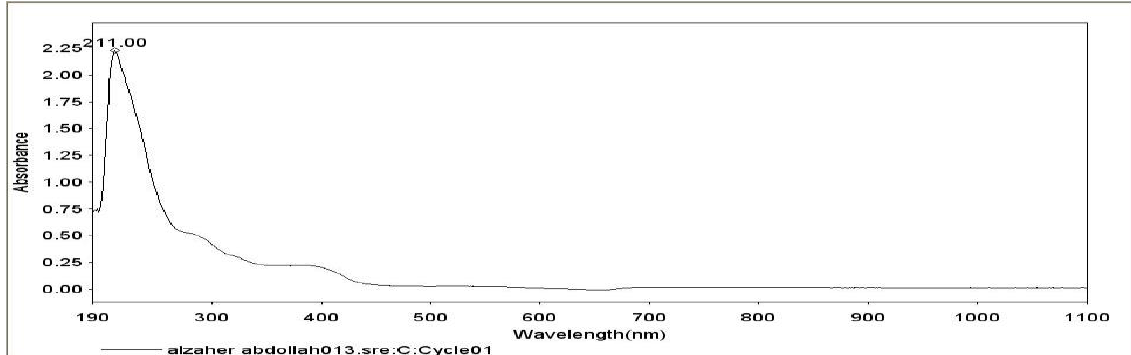
Figure 6. The ʎ max spectrum for dihydrocodeine. The ʎ max spectrum for the extracted alkaloid was 211 nm which is a typical